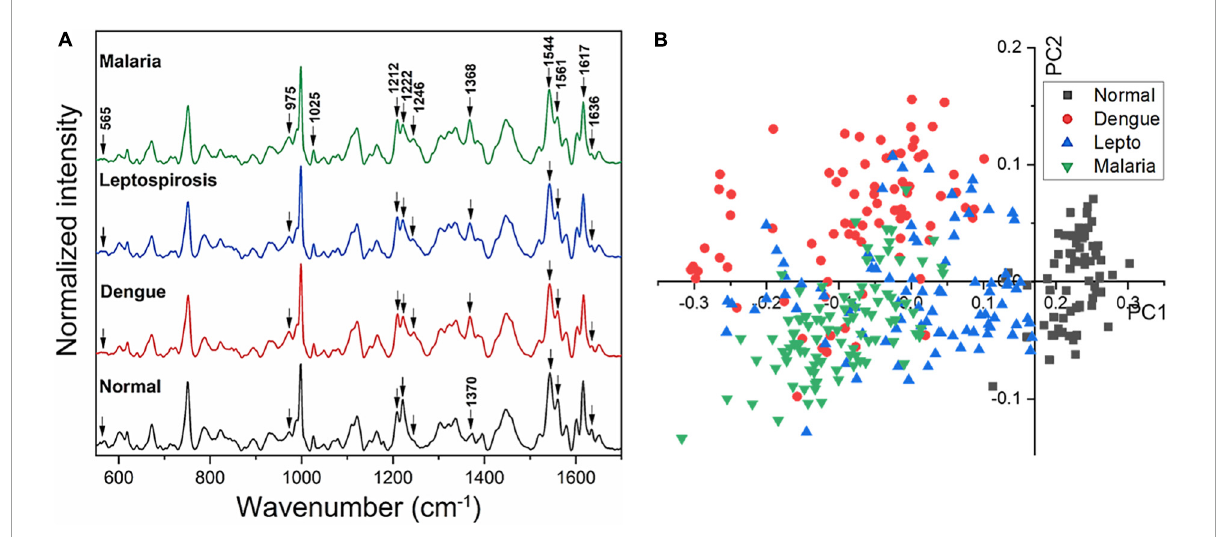
FIGURE2 (A) Averaged Raman spectra of RBCs from blood samples of healthy volunteers and patients with malaria, dengue and leptospirosis and (B) PLS-DA score plot of the first two PCs between RBCs of healthy and the disease samples.